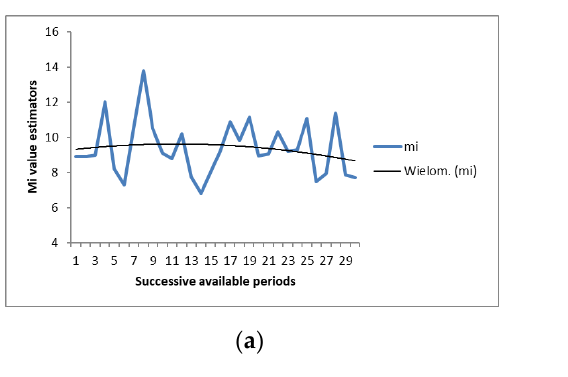
Figure 5. Values of estimators together with the fitted functions for: ( a ) m 1 ,…, m 30 ; ( b ) σ 1 ,…, σ 30 . Table 4. Calculation of distribution parameters m̂ 31 , σ ̂ 31 describing the disassembly times of the joint predicted for Rec.